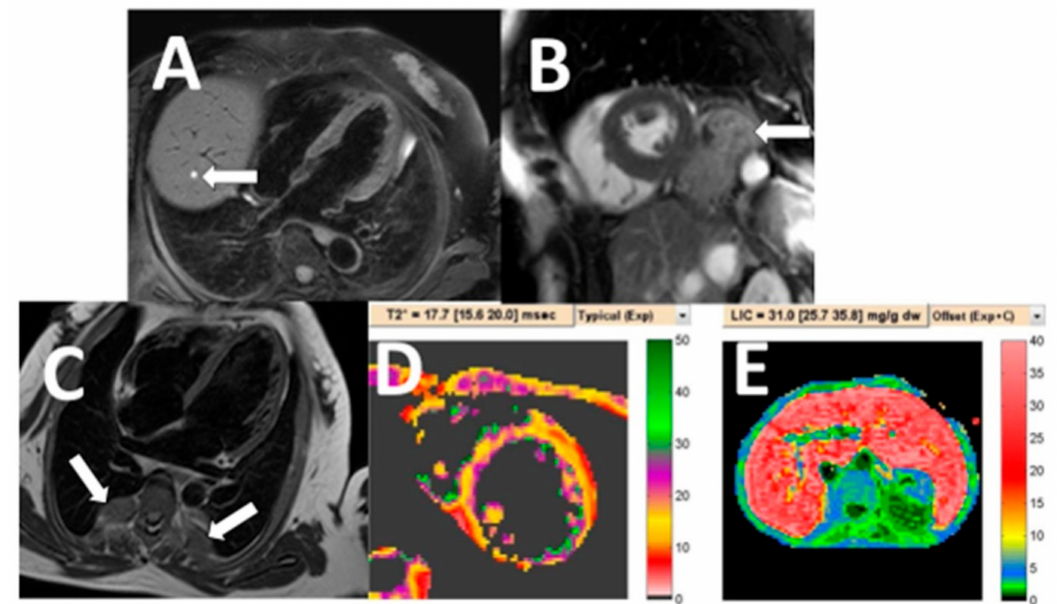
Figure 1. Examples of irrelevant non-cardiac abnormality on cardiac MRI. A cardiac MRI black blood image of a 52-year-old woman revealed a small, simple liver cyst ( A : arrow). Cardiac MRI white blood image in short-axis plane detected hiatal hernia ( B : arrow). Incidentally found extramedullary hematopoiesis ( C : arrows) of thalassemia patient who underwent CMR for iron concentration quantification in the heart ( D ) and liver ( E ).